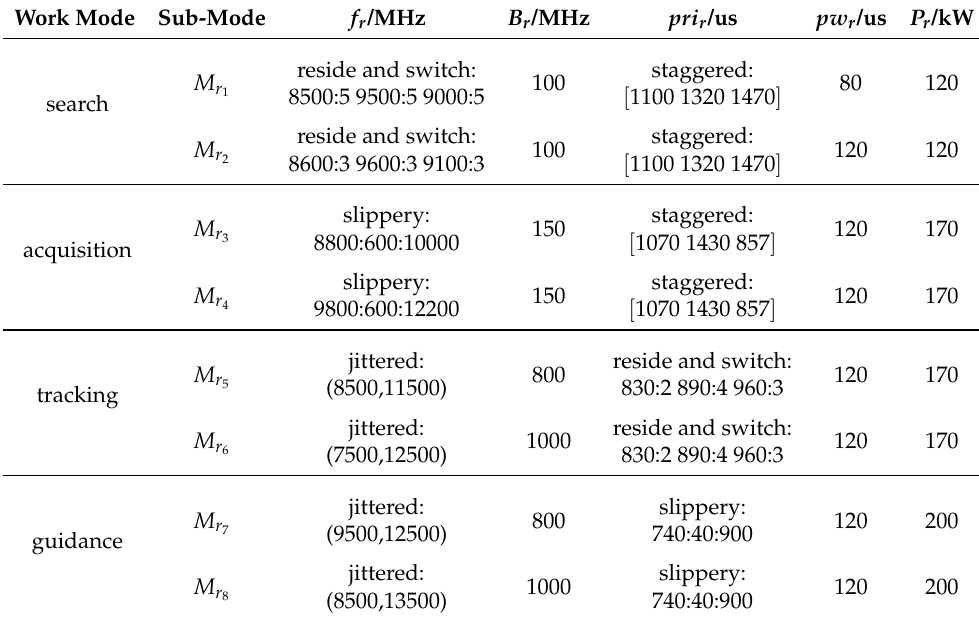
Table 1. Radar parameter template. When the radar is at a certain mode, it selects the pulse parameters according to the rules in the template. Reside and switch, slippery, staggered, and jittered are four of the common radar parameter agility patterns. As shown, reside and switch A:k B:m C:n means that the parameter value stays at A for k pulses, stays at B for m pulses, and stays at C for n pulses; slippery A:B:C means that the parameter value changes from A to C in steps of B; staggered such as [ A B C ] means that the parameter value is cycled in the order of the list; jittered such as (A,B) means the parameter value is randomly selected from the range of A to B.